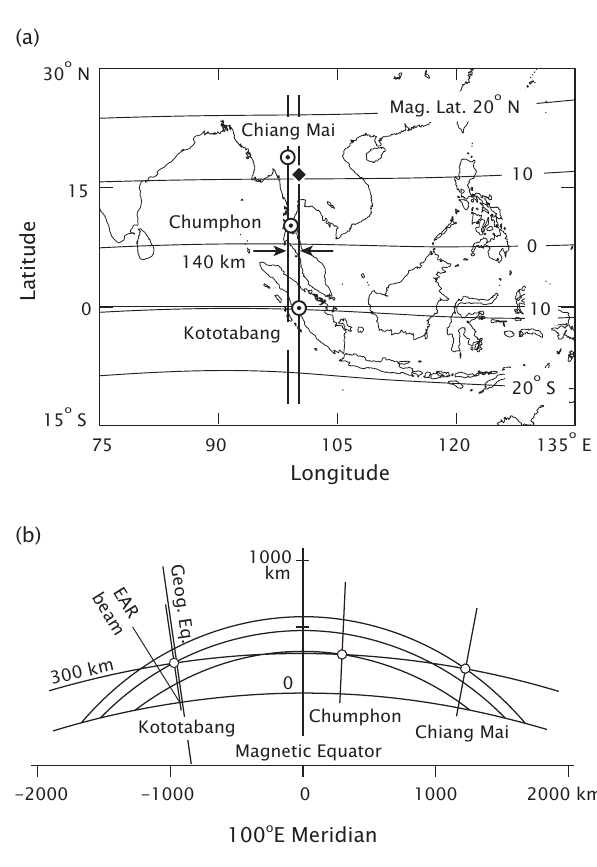
Fig. 1. (a) Locations of the three ionosondes of SEALION, and (b) magnetic field lines passing 300km above each ionosonde along the 100 ◦ E meridian. The beam direction of the EAR (Equatorial Atmosphere Radar) for field aligned irregularity observation is over- laid in panel (b).